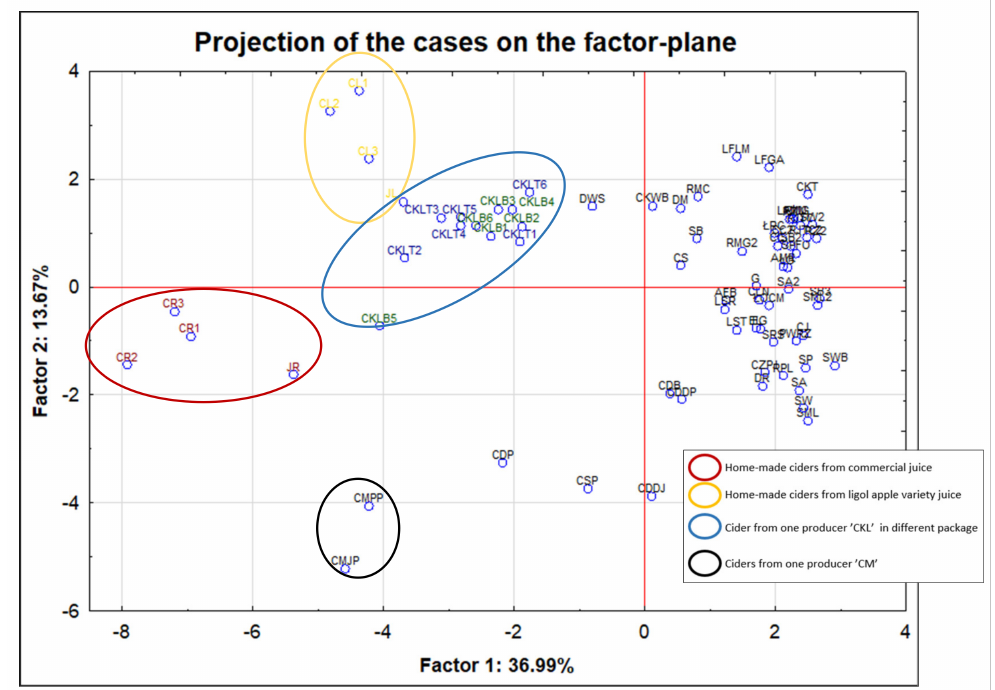
Figure 2. Projection of the cases on the factor-plane in 73 samples investigated in this study according to their producer